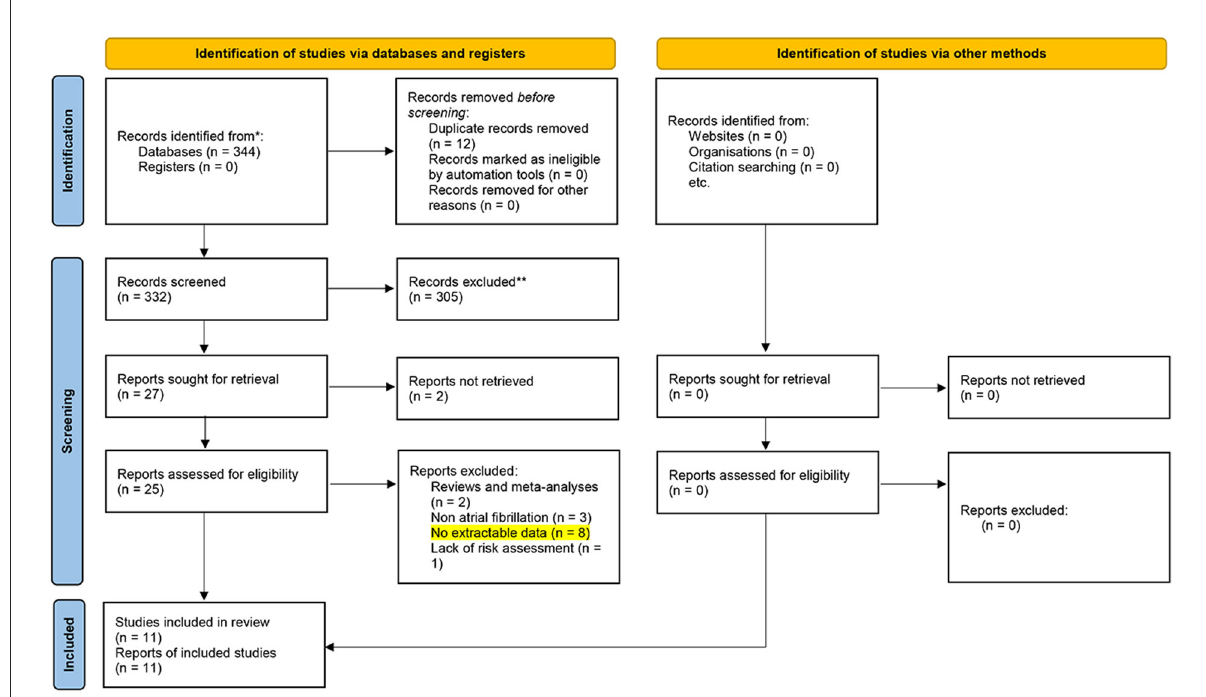
FIGURE1 The study screening flowchart. *Consider, if feasible to do so, reporting the number of records identified from each database or register searched (rather than the total number across all databases/registers). **If automation tools were used, indicate how many records were excluded by a human and how many were excluded by automation